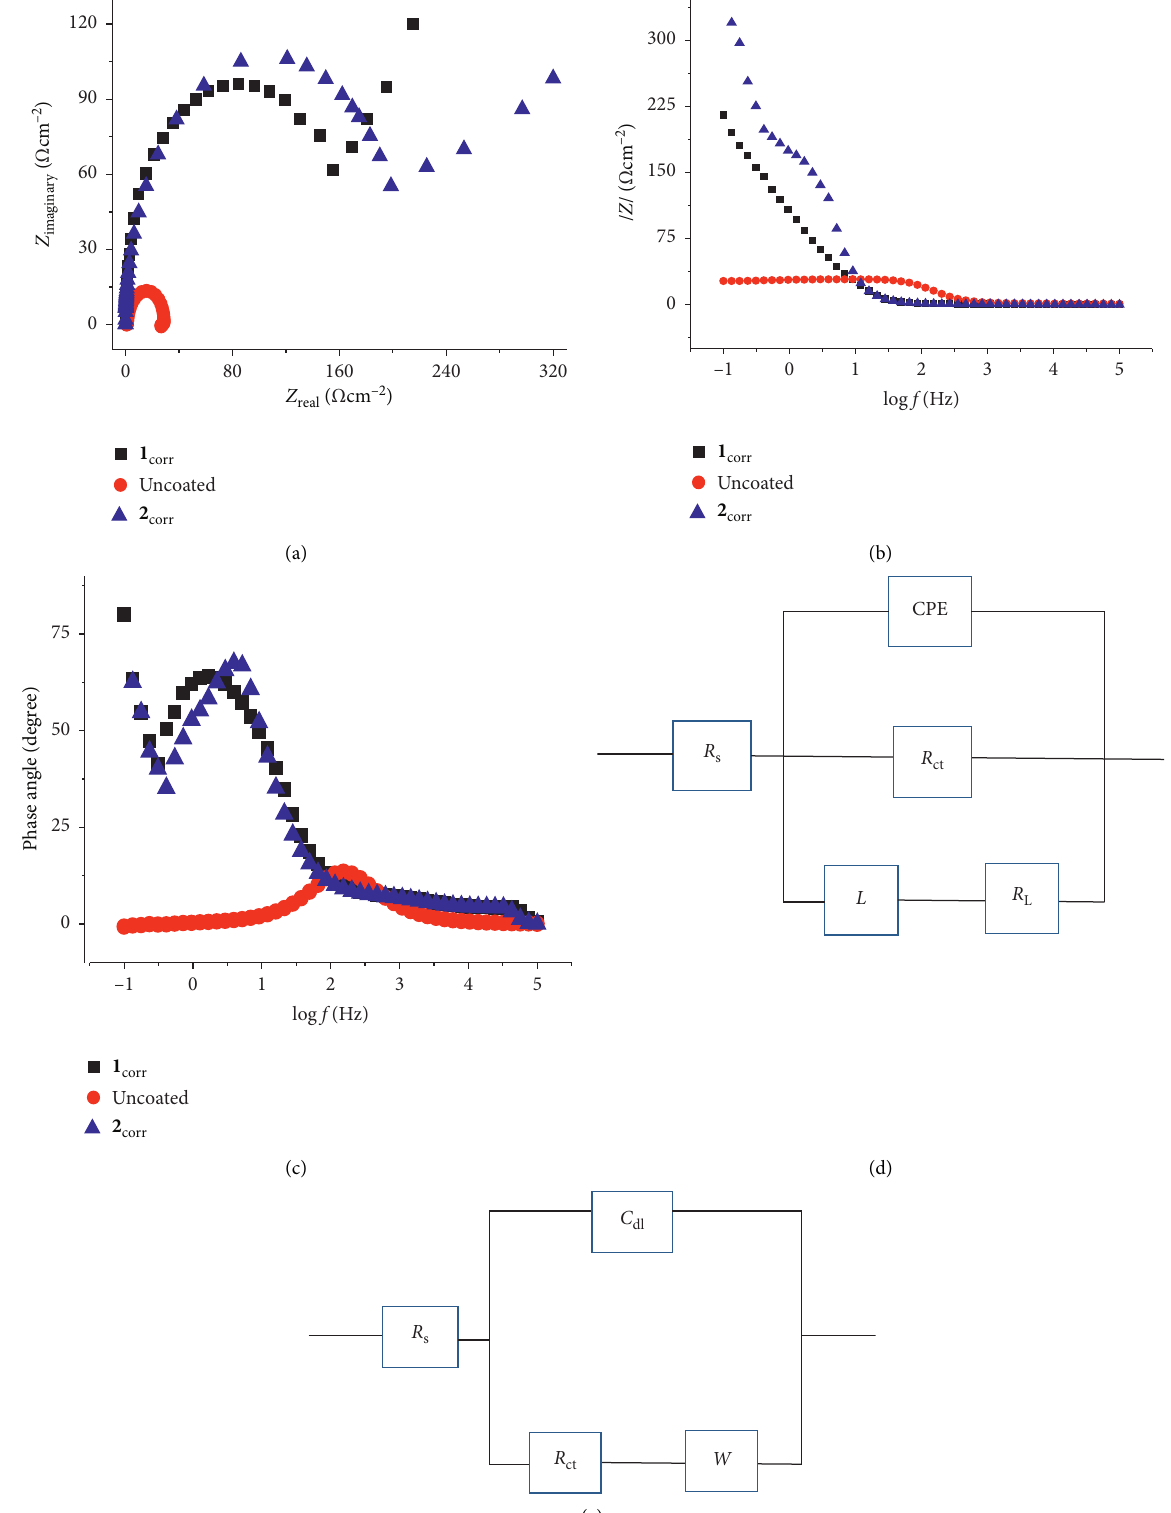
Figure 6: EIS data for aluminium in 1.0 M hydrochloric acid solution in the presence of electrodeposited- 1 and electrodeposited- 2 coatings (represented as 1 corr and 2 corr , respectively) and without coating. (a) Nyquist plots and Bode plots, (b) log Z vs. log f , and (c) phase angle ( f ) vs. log f . (d, e) Equivalent circuits used to fit EIS data for uncoated aluminium and coated aluminium,